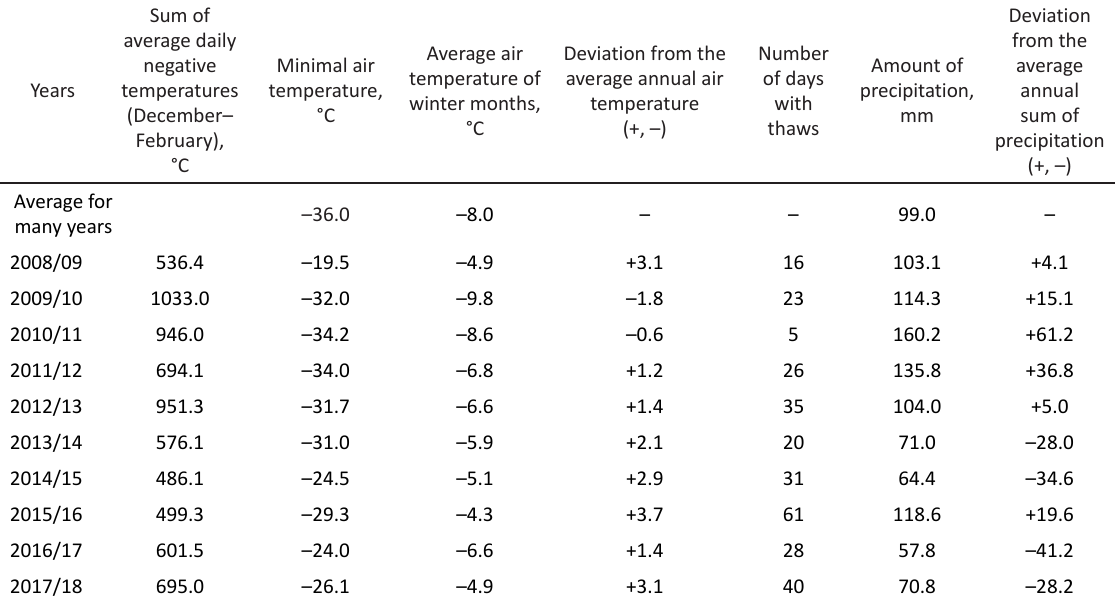
Table 1. Meteorological conditions of the winter period from 2008 to 2018 (December–February) (Data from the VNIISPK weather station) Sum of average daily negative Years